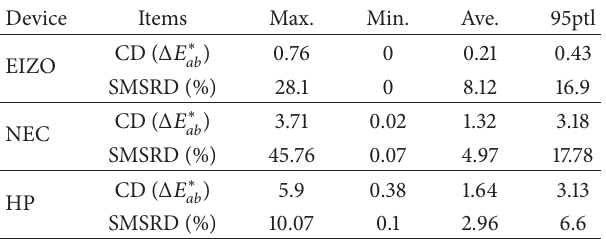
Table 1: Difference between 𝜌 0 and 𝜌 1 of 216 test samples for forward color-characterization